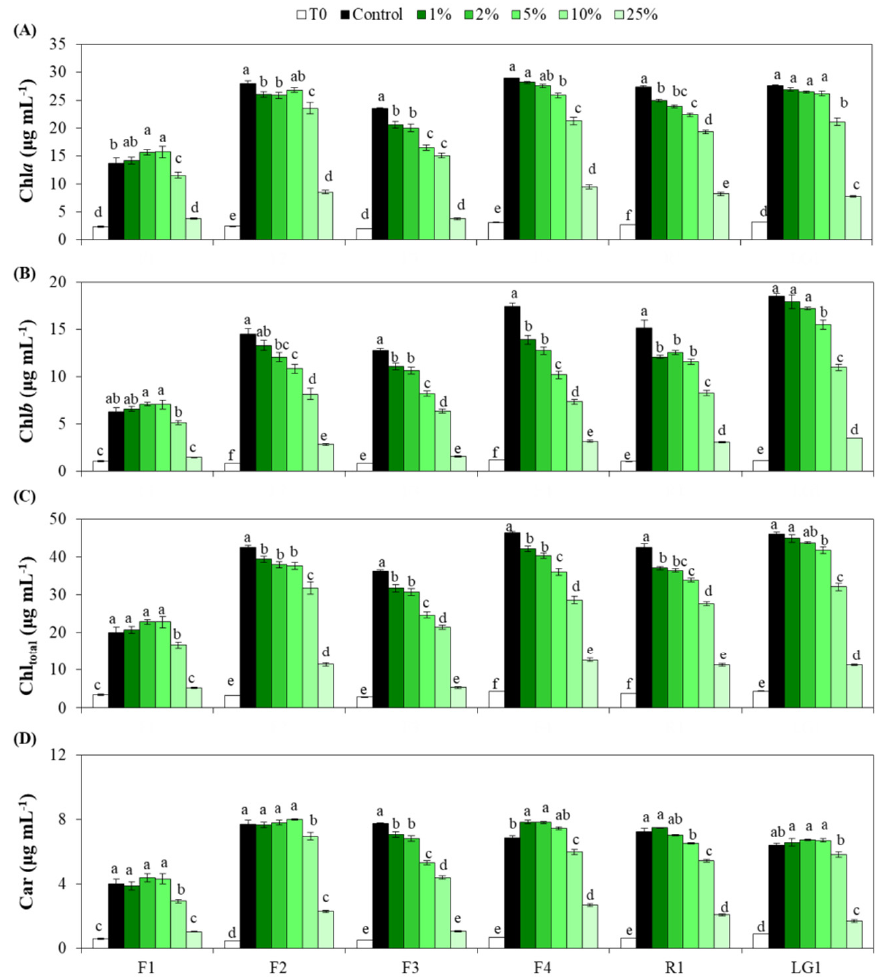
Figure 2. Effect of wastewater from cigarette butts (CB) cleaning process on photosynthetic pigments of six microalgal strains. ( A ) Chlorophyll a (Chl a ), ( B ) chlorophyll b (Chl b ), ( C ) total chlorophyll (Chl total ) and ( D ) carotenoids (Car) were determined in each microalgal strain (F1, F2, F3, F4, R1 and LG1) at the beginning of the experiment (T0) and 7 days after treatment. Microalgal treatment included exposure to growth medium without CB wastewater (Control) or containing different CB wastewater dilutions (1, 2, 5, 10 and 25%). Different letters represent significant differences ( p < 0.05) between treatments within the same strain. Data are expressed as means of 4 different replicates ± standard error (SE).